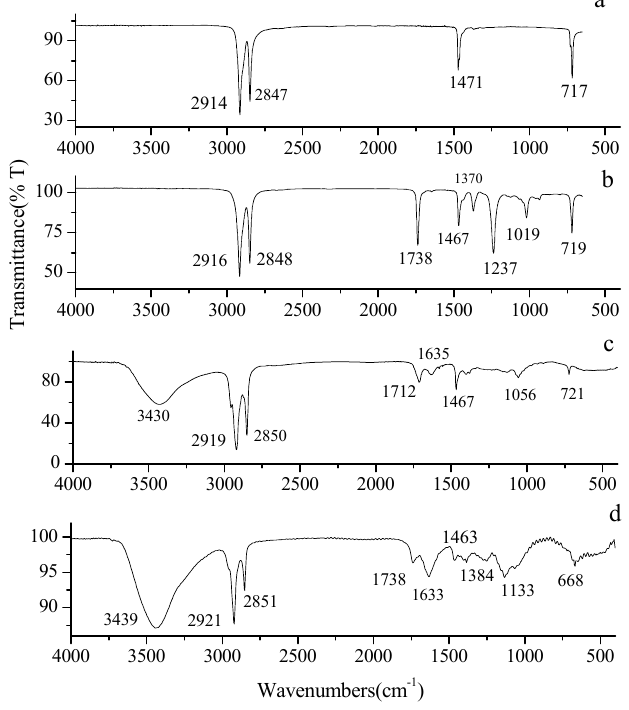
Figure 6. FT-IR spectra analysis. ( a ) FT-IR spectra of HDPE; ( b ) FT-IR spectra of EVA; ( c ) FT-IR spectra of eutectic mixture of TD-MA; ( d ) FT-IR spectra of FS TD-MA